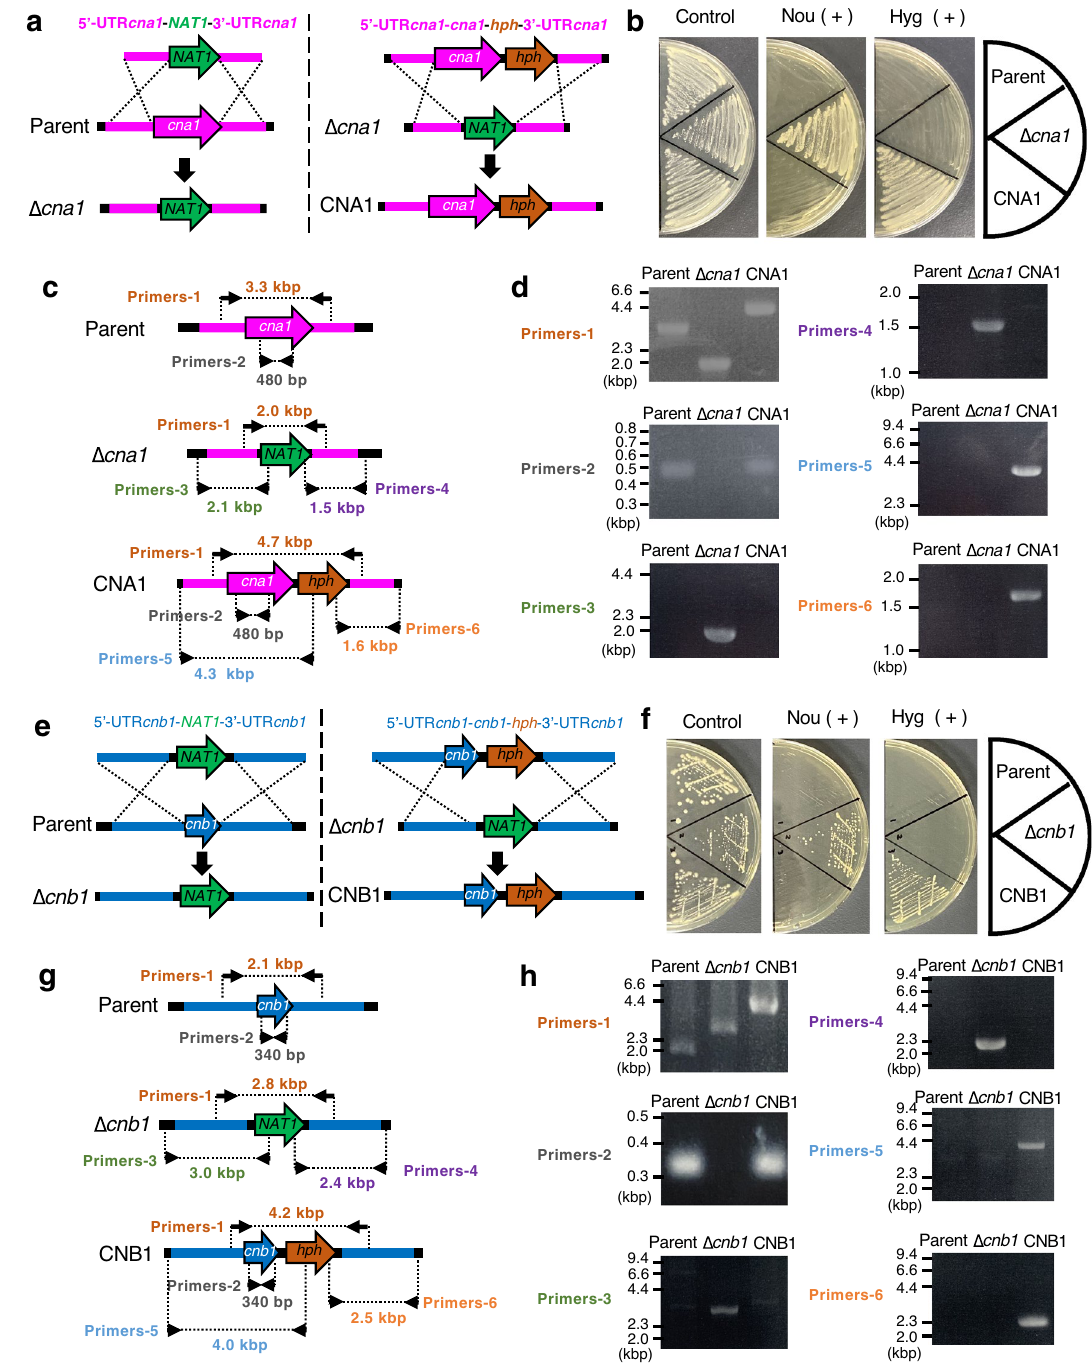
Figure 1. Generation of the cna1 and cnb1 gene-deficient T. asahii mutants and their revertants. ( a – d ) Generation of the cna1 gene- deficient mutant and its revertant in T. asahii . ( a ) Strategy for generating the cna1 gene-deficient mutant (∆ cna1 ) and its revertant (Rev.). Predicted genomes of the cna1 gene-deficient mutant and its revertant are shown. ( b ) The parent strain (Parent), cna1 gene-deficient mutant (∆ cna1 ), and its revertant (Rev.) were spread on SDA with nourseothricin (Nou) (100 µg/ml) or hygromycin B (Hyg) (100 µg/ml) and incubated at 27 °C for 2 days. ( c ) Location of the primers for confirming the genome structure of the cna1 gene-deficient candidate by PCR using extracted genome DNA. ( d ) Confirmation of the genotypes of the cna1 gene-deficient mutant (∆ cna1 ) and its revertant (Rev.) by PCR using extracted genome DNA. ( e – h ) Generation of the cna1 gene-deficient mutant and its revertant in T. asahii . ( e ) Strategy for generating the cnb1 gene-deficient mutant (∆ cnb1 ) and its revertant (Rev.). Predicted genomes of the cnb1 gene-deficient mutant and its revertant are shown. ( f ) The parent strain (Parent), cnb1 gene-deficient mutant (∆ cnb1 ), and its revertant (Rev.) were spread on SDA with nourseothricin (Nou) (100 µg/ml) or hygromycin B (Hyg) (100 µg/ml) and incubated at 27 °C for 2 days. ( g ) Location of the primers for confirming the genome structure of the cnb1 gene-deficient candidate by PCR using extracted genome DNA. ( h ) Confirmation of the genotypes of the cnb1 gene-deficient mutant (∆ cnb1 ) and its revertant (Rev.) by PCR using extracted genome DNA. Cropped blots were used. Full-length blots are presented in Supplementary Fig.